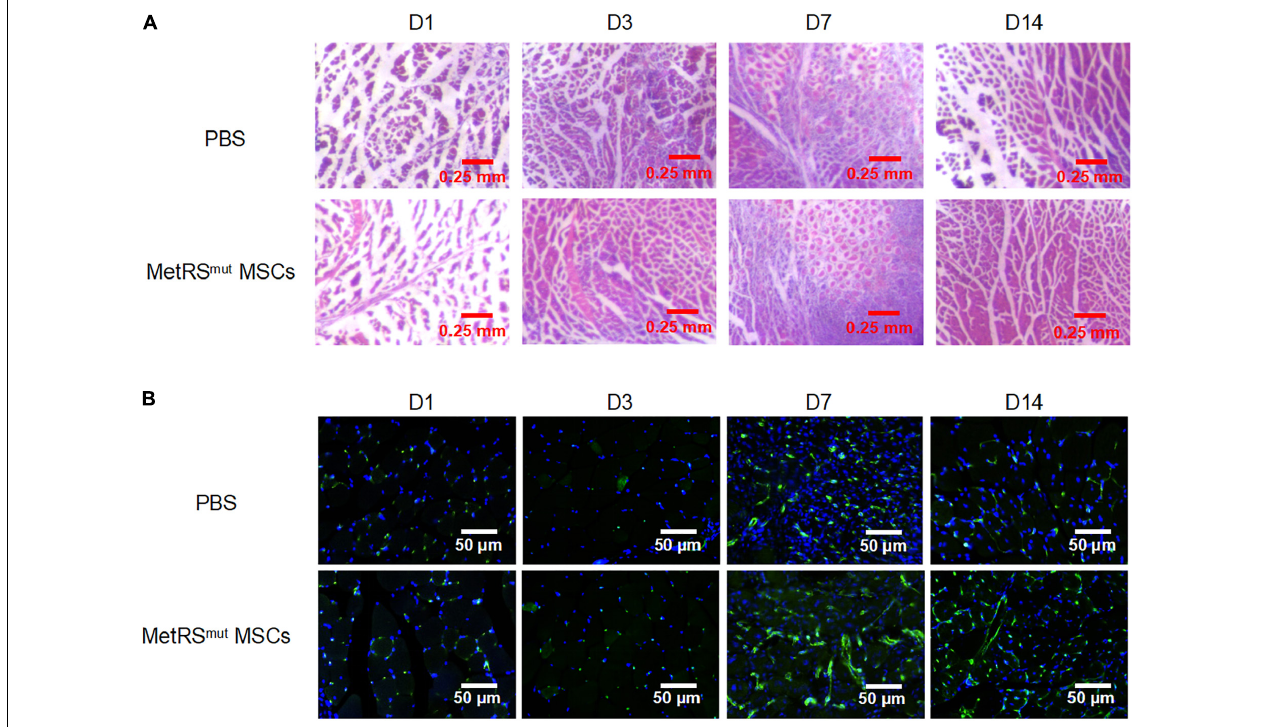
FIGURE 3 | Histological analysis of ischemic hindlimb by HE and vessel staining. Gastrocnemius muscles in HLI group transplanted with either mutant cells or PBS were collected and processed for HE staining (A ) and CD31 staining (B) . Scale bar, 250 µ m for (A) and 50 µ m for (B) .